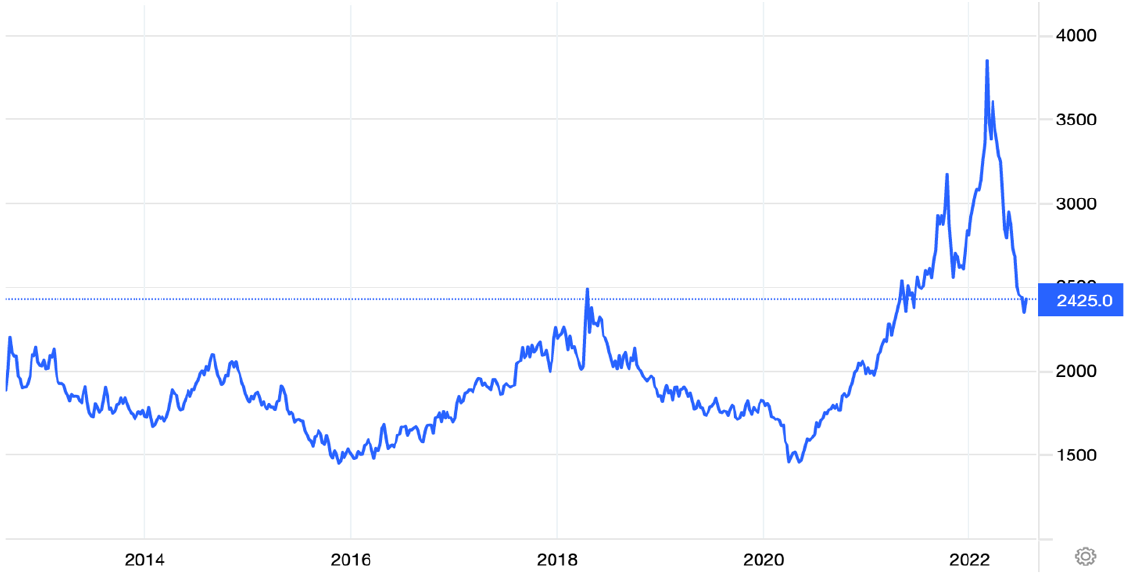
Figure 12. Aluminum prices in USD in the last decade.